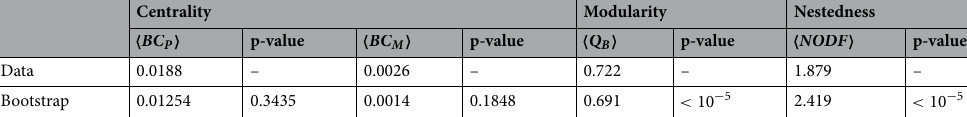
Table 2. Structural properties of the photobiont-mycobiont network. From left to right, mean betweenness centrality for photobionts and mycobionts ( BC P and BC M respectively), modularity ( Q B ) and whole nestedness ( NODF ). Null model metrics were calculated from 100 independent realizations of the network. P-values were obtained from t-test statistics in normally distributed variables ( Q B , NODF ) or Mann-Whitney U rank non- parametric test in non-normally distributed data ( BC P and BC M